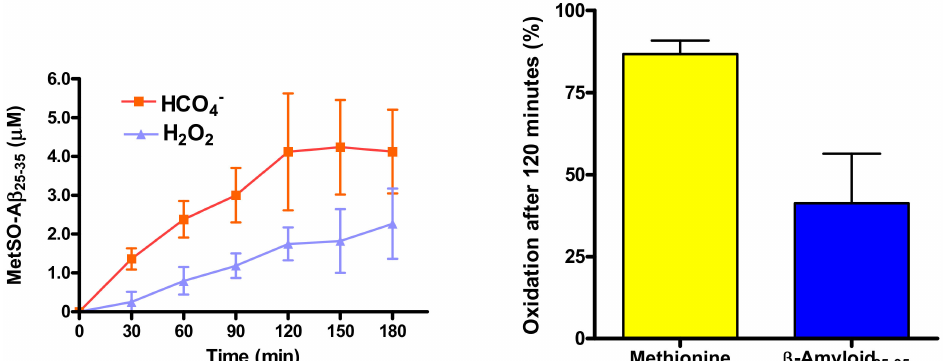
Figure 4. Time course of A β 25-35 oxidation by peroxymonocarbonate or hydrogen peroxide ( left ). A β 25-35 and L-methionine oxidation by peroxymonocarbonate at 120 min ( right ). To reaction mixture containing 10 µ M A β 25-35 or 10 µ M L-methionine in 0.1 M phosphate bu ff er, pH 7.4, and 0.1 mM DTPA, peroxymonocarbonate was added at 0.8 mM final concentration. Hydrogen peroxide was 5 mM. At various time intervals of incubation at 37 ◦ C, the reaction was stopped by addition of catalase (400 U / mL) and the reaction products analyzed by